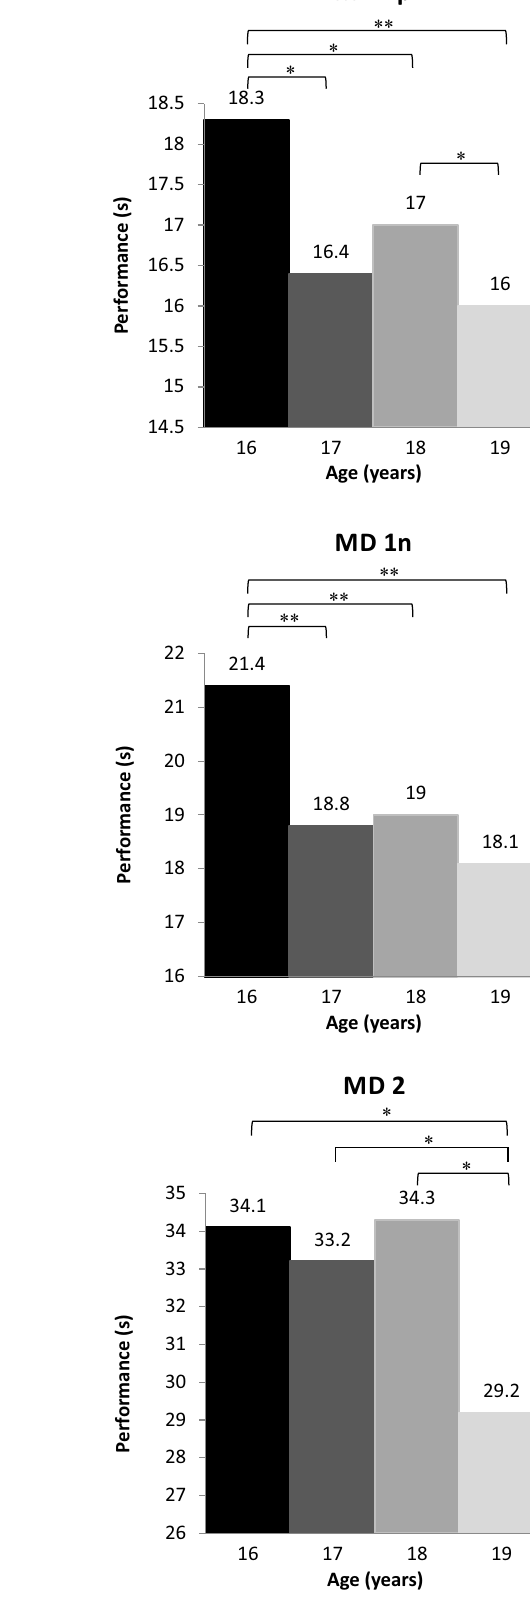
Figure 1. Post-hoc comparison of Turning pegs – pre- ferred hand (MD 1p), Turning pegs – non-preferred hand (MD 1n), and Triangle with nuts and bolts (MD 2) tasks. * p < .05, ** p <